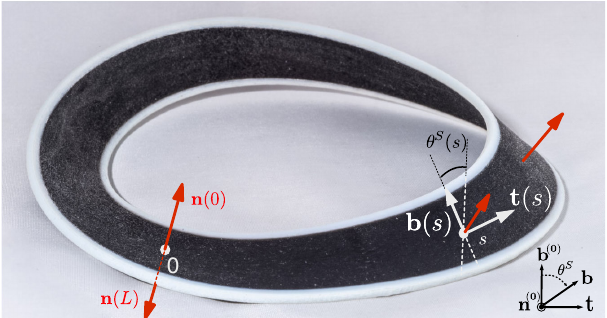
FIG. 1. A nonorientable elastic ribbon. Example of a 3D- printed Möbius strip of width 1 cm. The tangent and binormal vectors t ð s Þ and b ð s Þ are indicated with white arrows, the normal vectors n ð s Þ with red arrows. The shear deformations in the ( t ; b ) plane are measured by the rotation angle θ s ð s Þ defined with respect to the local normal vector n ð s Þ . Note that n ð s Þ reverses its sign after one full turn around the strip n ð 0 Þ ¼ − n ð L Þ .